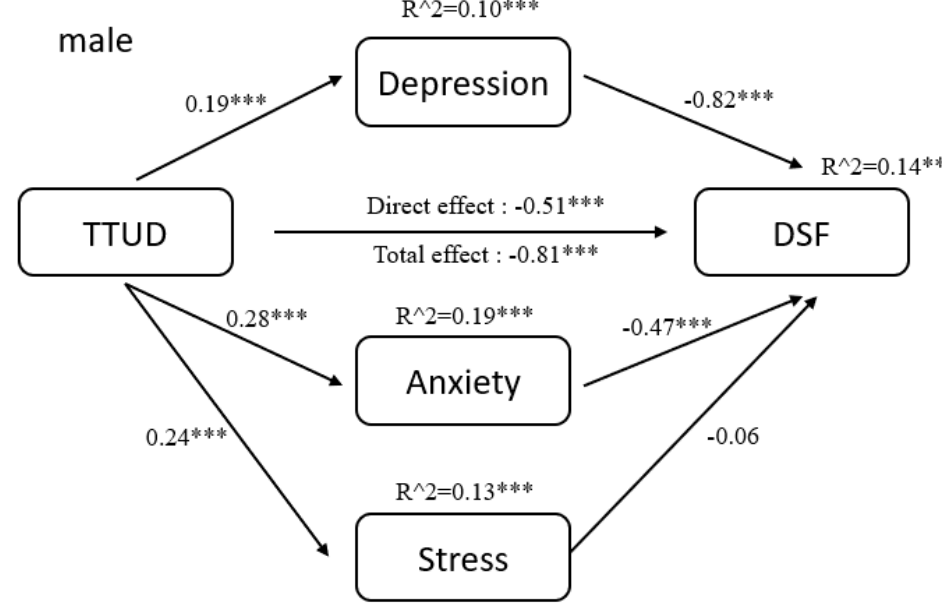
Figure 4. Structural model of forward digit span test for male participants. ** p < 0.01, *** p < 0.001.